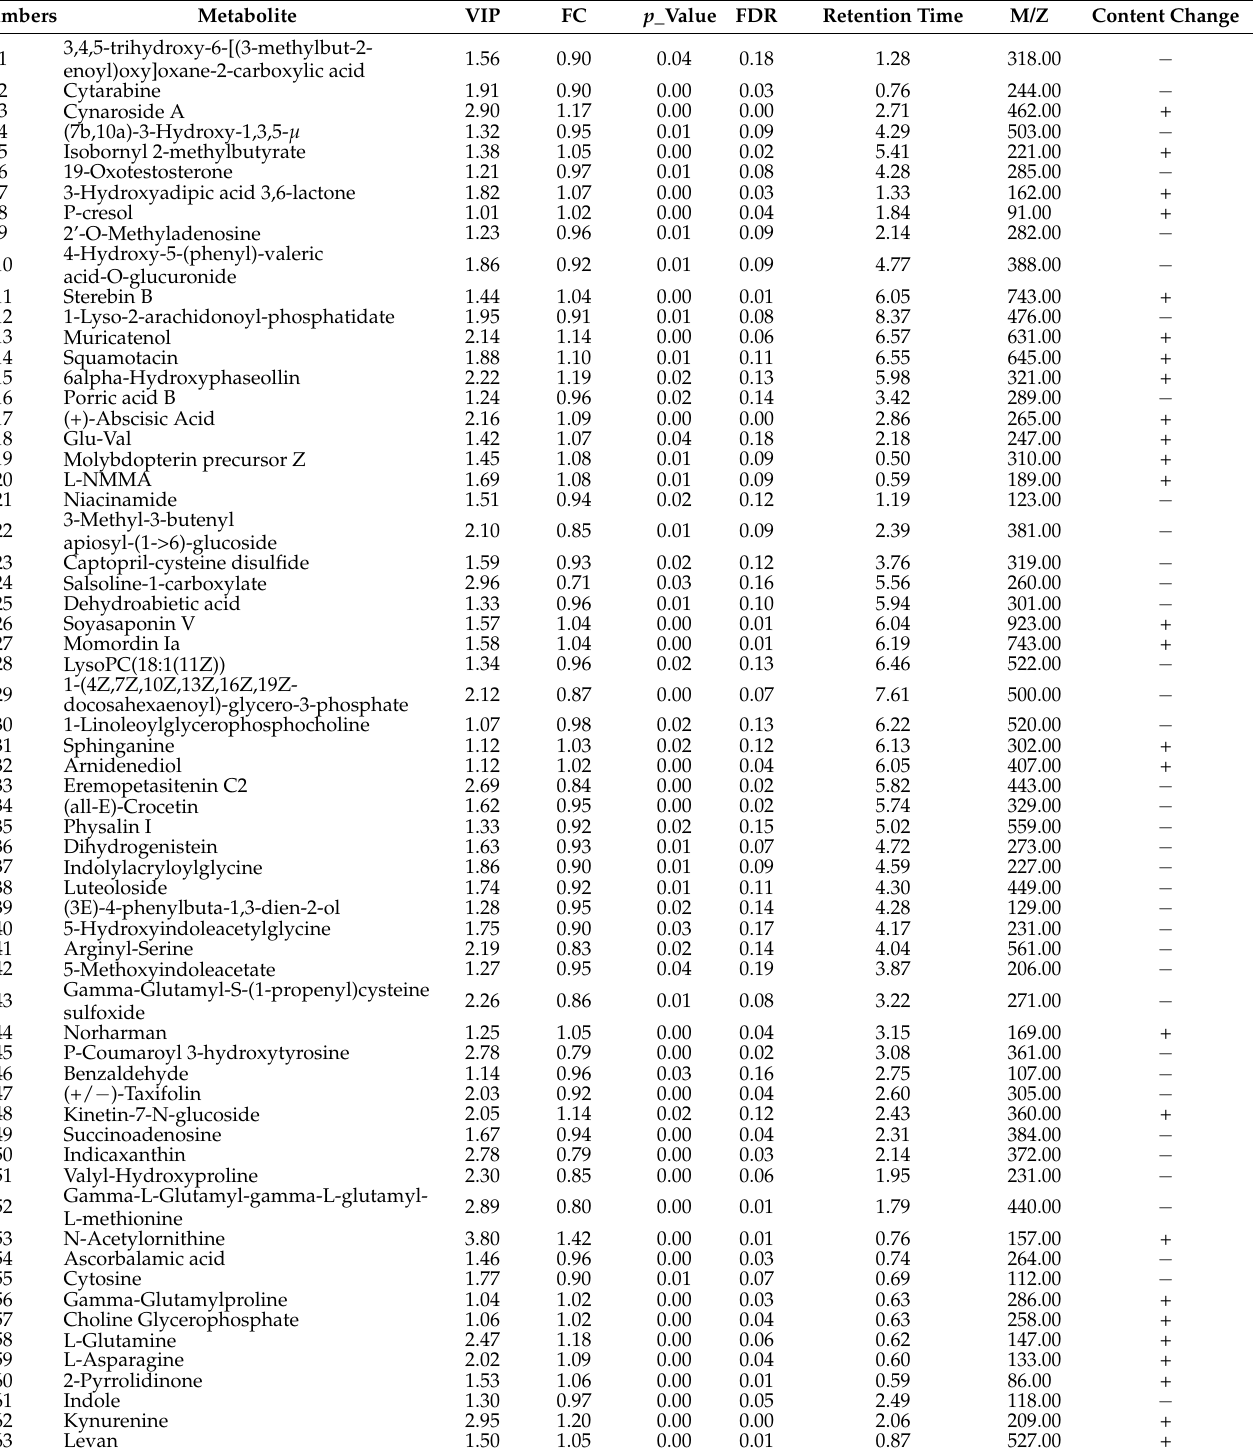
Table 2. Statistical Table of differential metabolites of the Vigna angularis Z-2-GS-2 vs. GS